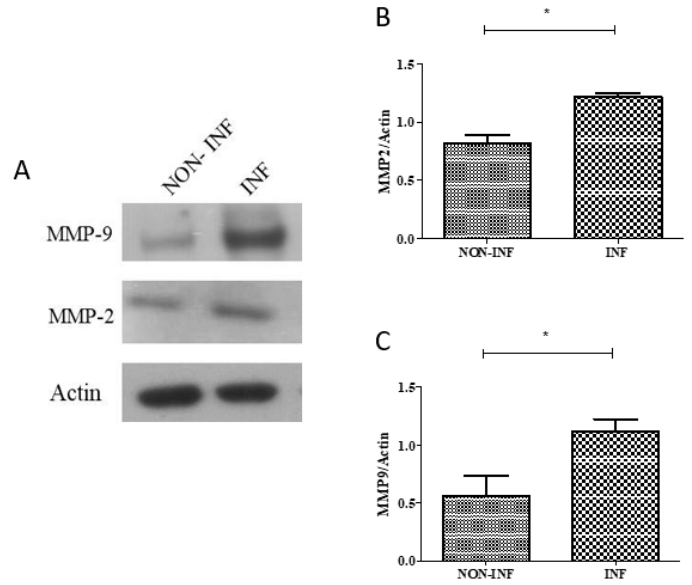
Figure 4. MMP2 (74 kDa; A and B ) and MMP9 (92 kDa; A and C ) protein expression in colon biopsies